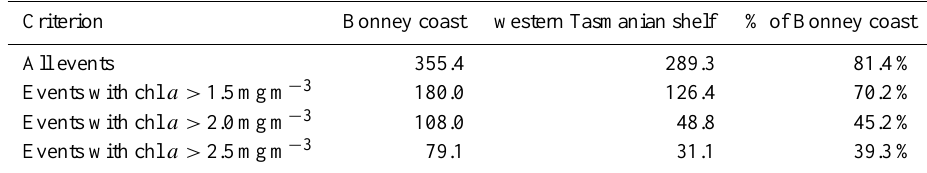
Table 3. Relative production (mgm − 3 ) for the Bonney coast and the western Tasmanian shelf (1 January 2005 to 31 March 2014) for different chlorophyll a